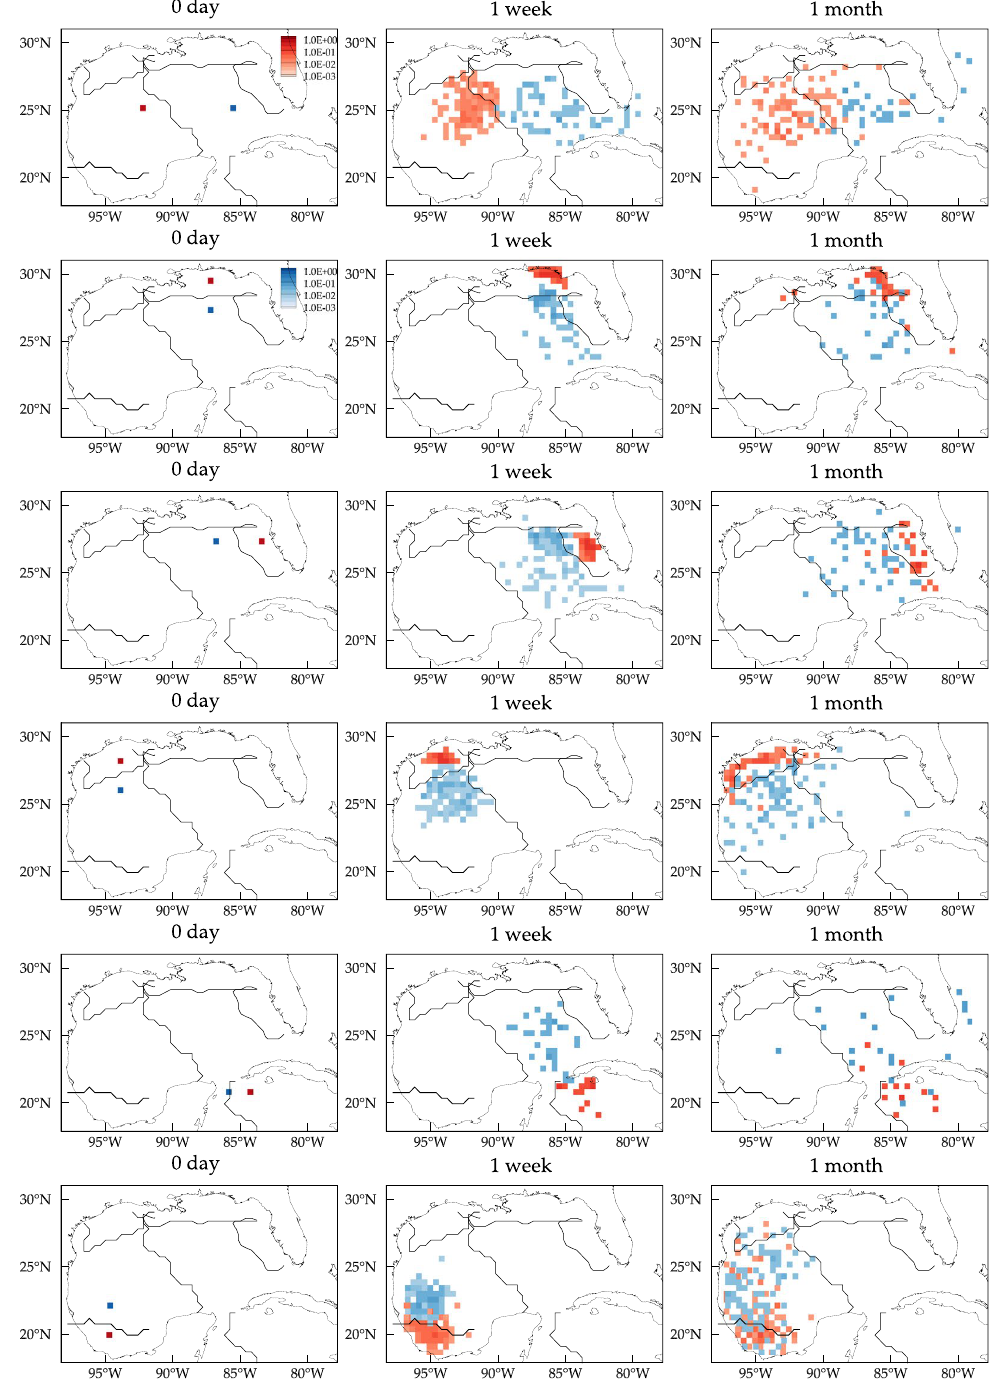
Figure 8. Evolution of normalized drifter densities for all drifters that have gone through the locations indicated in the left column at some point in time. Computations carried using Matlab R2017a (http://www. mathworks.com/) and visualization using Tecplot 360 2016 R2